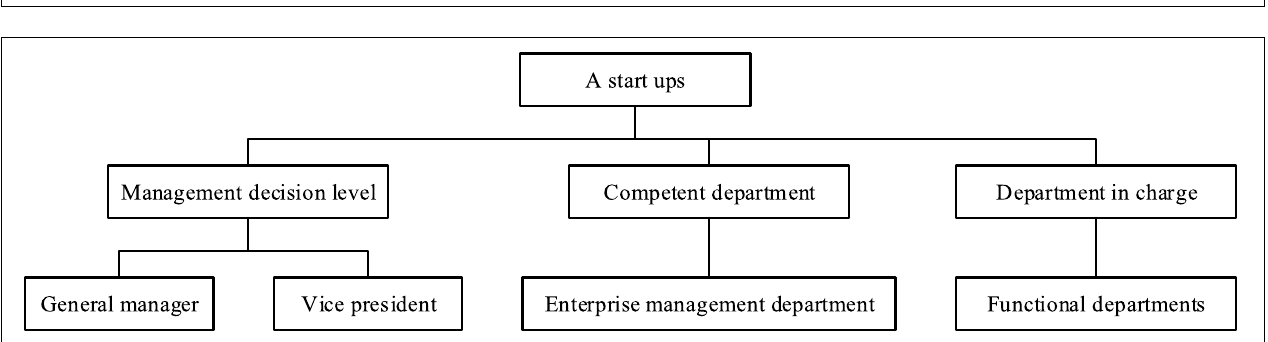
FIGURE 2 | Distinguishing dimensions of the causal attribution theory.